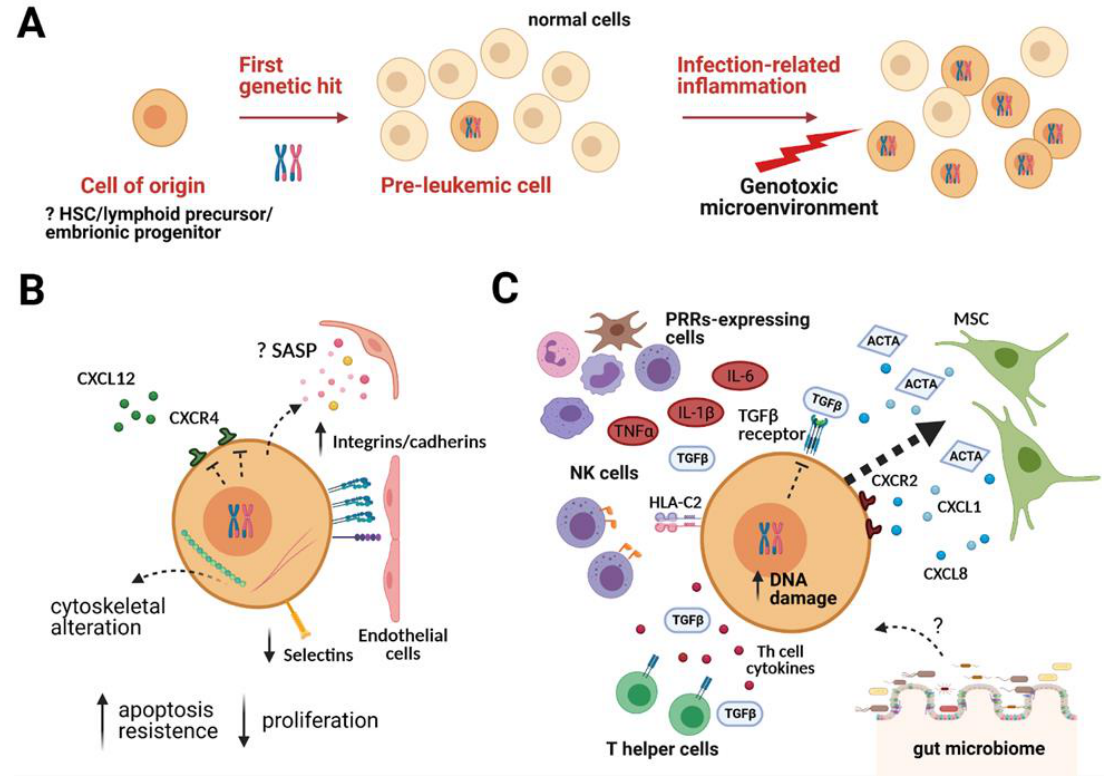
Figure 1. The pre-leukemic cell evolution and its interaction with the microenvironment. ( A ). Model of pre-leukemic evolution to leukemia. The initiating lesion, often a chromosome translocation, occurs in a cell of origin that can differ depending on the first hit and generates a very small clonal population of pre-leukemic cells. Infection-related inflammation is able to create a favorable niche for pre-leukemic cells at the expense of normal cells and promotes their genetic instability, leading to disease manifestation. ( B ) The pre-leukemic cell in the BM niche. Clinical and experimental evidence leads to the hypothesis that pre-leukemic cells are low proliferating and particularly resistant to apoptotic stimuli. The first genetic hit can cause cytoskeletal alterations, dysregulate the expression of adhesion molecules (such as integrins, cadherins, and selectins), and modify cell migration and adhesion properties of pre-leukemic cells (CXCL12-CXCR4 axis impairment and increased ability to adhere to endothelial cells have been reported in in vitro studies). Moreover, pre-tumoral cells can activate a senescence-associated secretory phenotype (SASP, yellow and pink dots) able to influence the surrounding microenvironment (e.g., stimulate endothelial proliferation). ( C ) The pre-leukemic cell in BM niche after an infectious event. We recently showed that the pro-inflammatory cytokines IL-6, TNFα, and IL-1β secreted in response to infections by pattern recognition receptors (PRRs)-expressing cells, cooperate with mesenchymal stromal cells (MSCs) to create a favorable niche for ETV6-RUNX1+ pre-leukemic cells and predisposing them to transformation through increased DNA damage. In this context, MSCs secrete CXCR2 ligands (e.g., CXCL1 and CXCL8, blue dots), attracting ETV6-RUNX1+ cells in a CXCR2-dependent manner (thick dashed arrow), and ActivinA (ACTA), a TGFβ family member. The pre-leukemic cells showed reduced sensitivity to TGFβ and ActivinA – mediated inhibition of proliferation. Furthermore, it has been proposed that T helper (Th) cells can support the growth and survival of pre-leukemic cells, also through the release of cytokines (red dots), including TGFβ. HLA-C2 binding to activating killer immunoglobulin-like receptors (KIRs, orange) on Natural Killer (NK) cells renders them hyporesponsive, thus facilitating immune escape and leukemia development. The gut microbiome is recently considered as a component of the tumor microenvironment, although its role in leukemia transformation is still unclear (“?” in the figure). Created with BioRender.com (accessed on 25 March 2021).